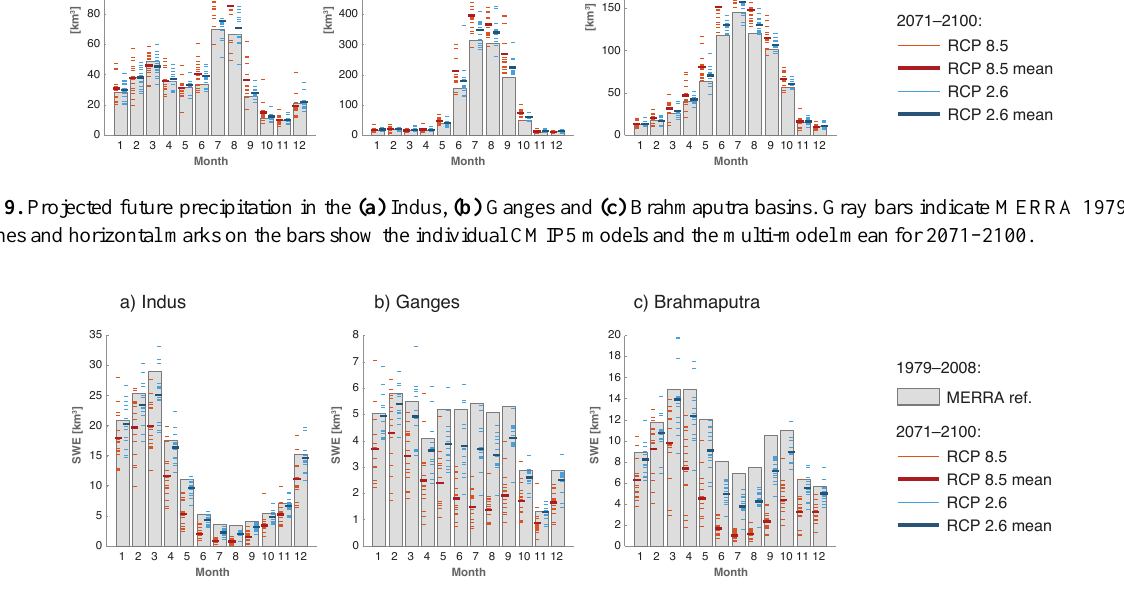
Figure 10. Projected future snowfall in the (a) Indus, (b) Ganges and (c) Brahmaputra basins, with reference to MERRA reference snowfall. Gray bars indicate MERRA reference snowfall for 1979–2008. Thin lines and horizontal marks on the bars show the individual CMIP5 models and the multi-model mean for 2071–2100 based on changes in temperature and precipitation, as described in Sect.